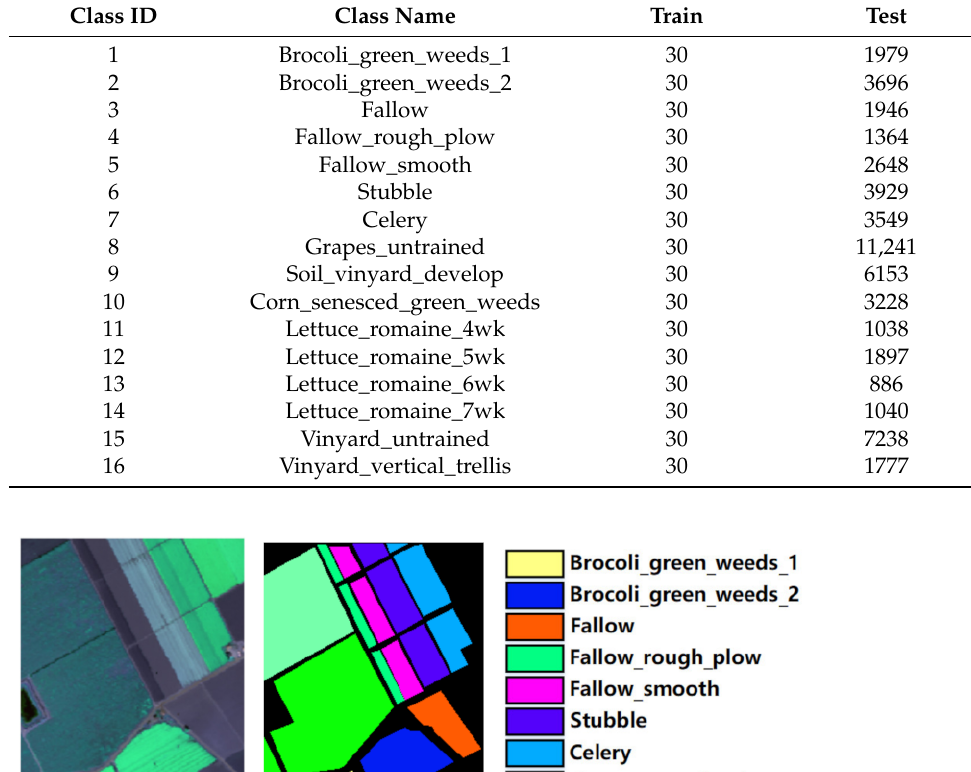
Table 4. Number of training and test sets for the Salinas dataset.